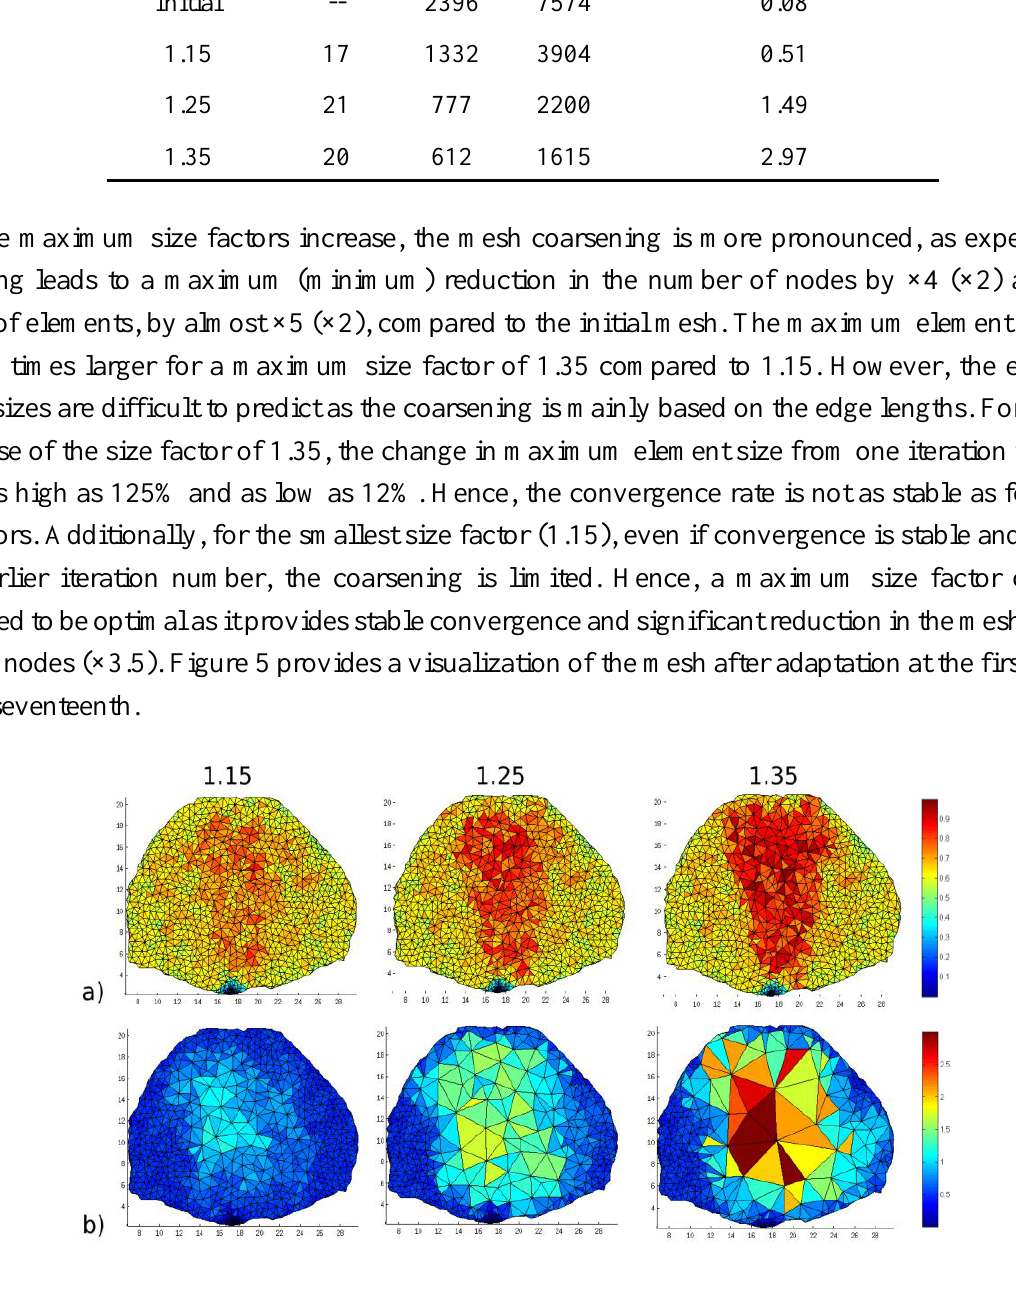
Figure 5. The mesh under different maximum size factors after ( a ) one iteration and ( b ) seventeen iterations, the greatest iteration all meshes achieve before convergence. Maximum size factors are provided as subtitles (color bar corresponds to volume of elements in mm 3